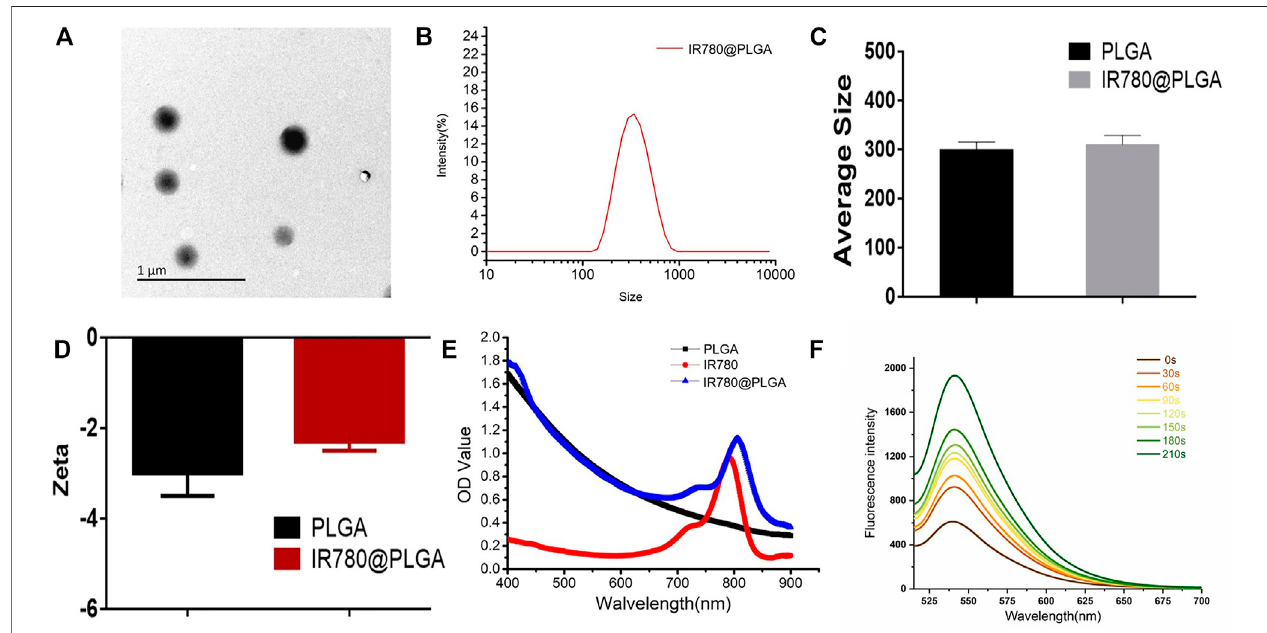
FIGURE 2 | (A) TEM image of IR780@PLGA nanoparticles (scale bar = 1 μ m). (B) Size intensity distribution of the IR780@PLGA nanoparticles. (C, D) Average diametersandsurfacezetapotentialofPLGAandIR780@PLGAnanoparticles. (E) UV-Vis-NIRabsorptionspectraofPLGA,IR780,andIR780@PLGAnanoparticles. (F) Time-dependent 1 O 2 generation of IR780@PLGA nanoparticles using SOSG as a fl uorescence probe with US irradiation (1 MHz, 2.0 W/cm 2